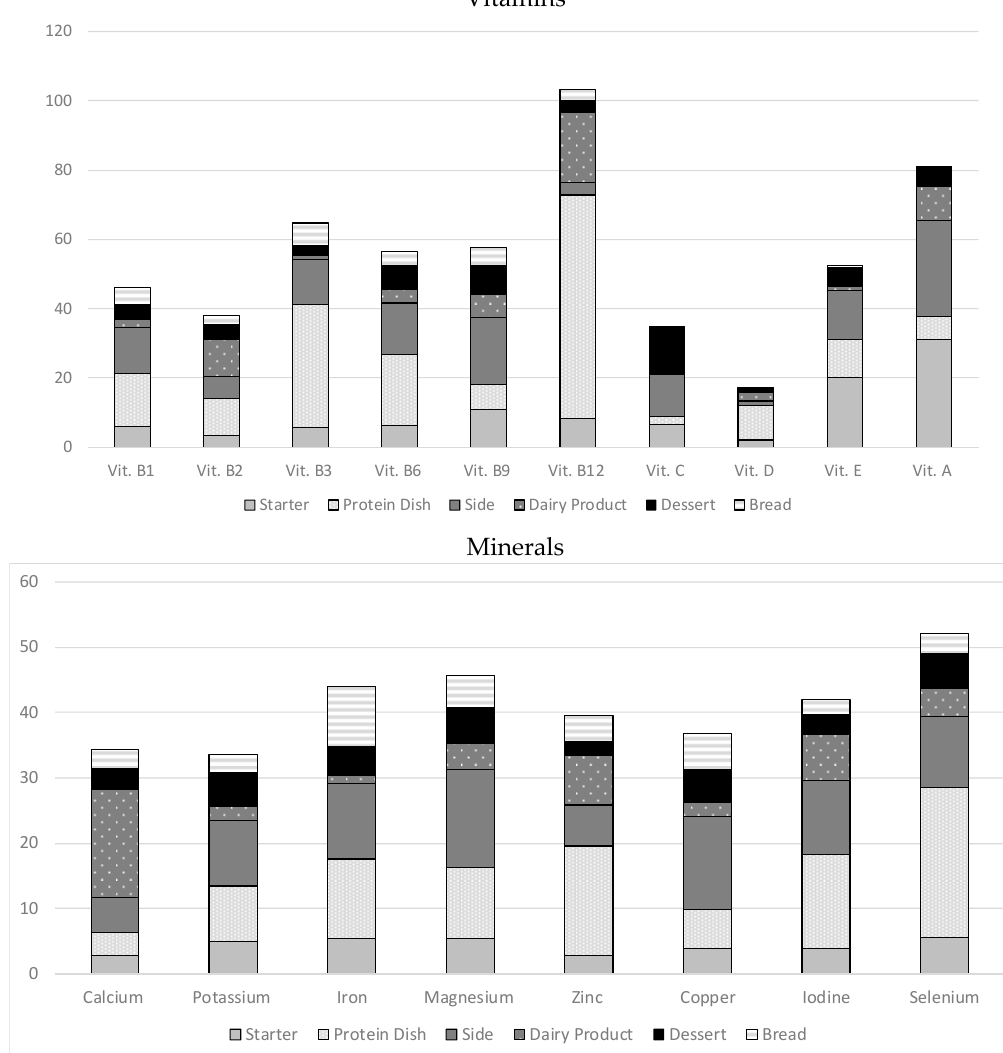
Figure A1. Average contributions of 5 meal components to the nutrient contents of the observed series ( n = 40 series of 20 meals), expressed in % of daily recommended intakes (multiplied by 20).